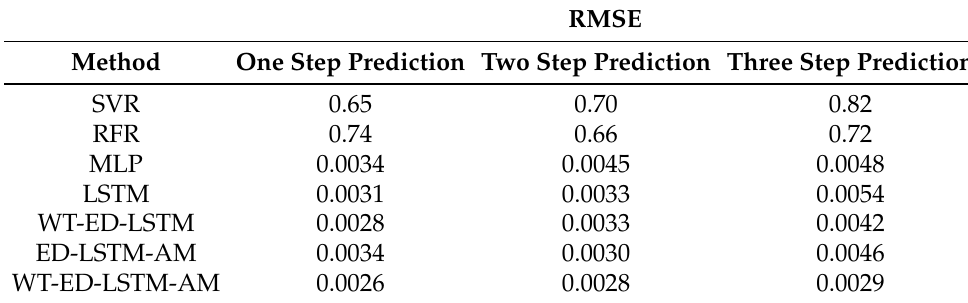
Table 1. Performance comparison of the WT-ED-LSTM-AM method to standard machine learning methods and the ablation study.